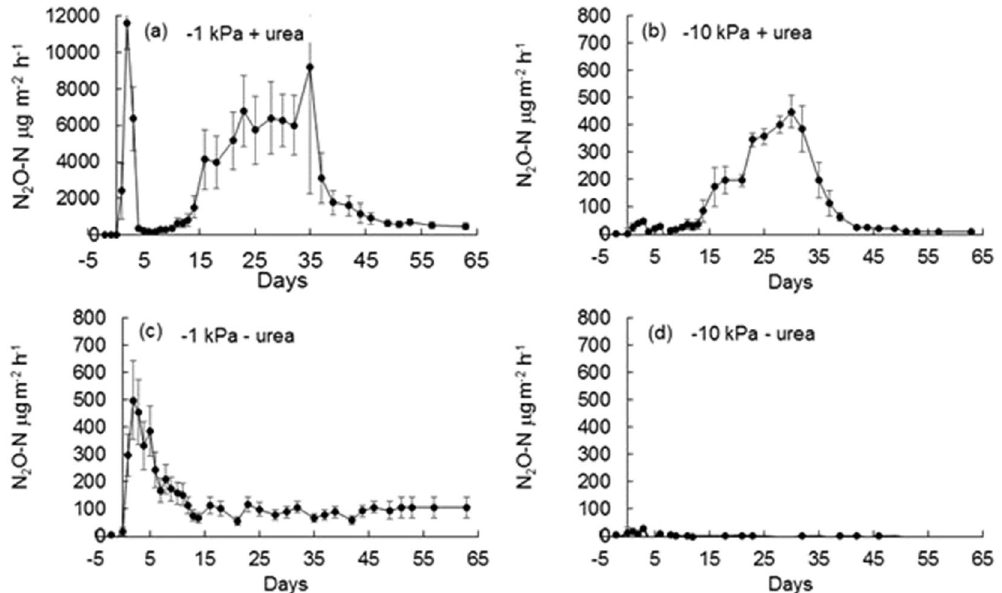
Figure 6. Nitrous oxide fluxes over time. Fluxes of N 2 O under near saturated ( − 1 kPa) or field capacity ( − 10 kPa) soil moisture conditions, following urea application ( + N) or nil urea application ( − N) where ( a ) − 1 kPa + N ( b ) − 10 kPa + N ( c ) − 1 kPa –N and ( d ) − 10 kPa –N show N 2 O fluxes over time. Note differing y-axis scales. Symbols are means (n = 4) with vertical error bars the standard error of the